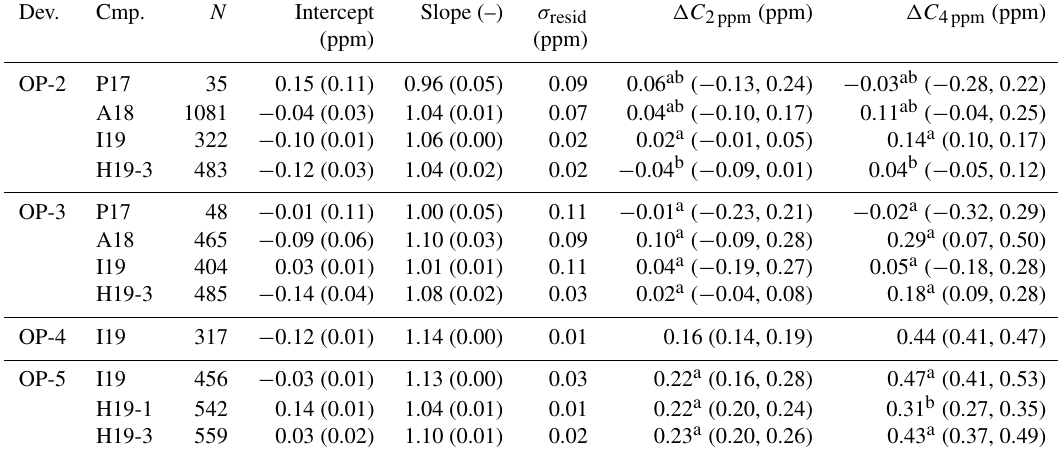
Table 5. Coefficients from the Deming regression between OP-1 and OP-2 to OP-5 with 30min averaged data. Standard errors of the estimates are given in parentheses. Only campaigns were analyzed, where N > 20 and the concentration range was large enough (difference between 0.025 and 0.975 quantiles greater than 0.4ppm). Dev.: GF3 device used as regressand. Cmp.: intercomparison campaign. N : number of 30min intervals. σ resid : standard deviation of the model residuals. (cid:49)C y ppm : predicted difference between the OP- x concentration and